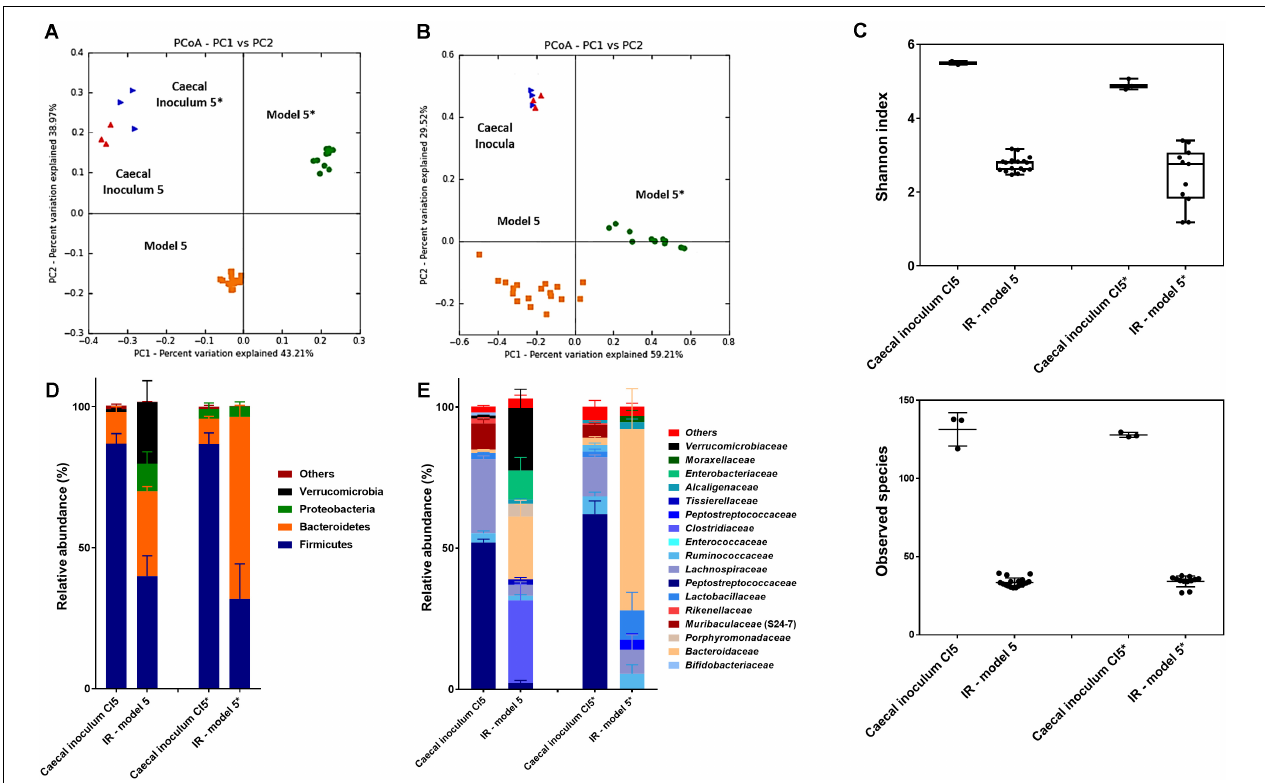
FIGURE 3 | Microbial composition and diversity analysis in caecal inocula and reactor effluents of model 5 and 5 ∗ . (A,B) Principle Coordinate Analysis (PCoA) of caecal inocula and reactor microbiota based on unweighted (A) and weighted (B) UniFrac analysis matrix on OTU level. Each point represents a microbiota sample from murine caecal content used as inoculum for model 5 (red (cid:78) ) and model 5 ∗ (blue (cid:73) ) or from stabilized reactor effluents of model 5 (orange (cid:4) ) and model 5 ∗ (green